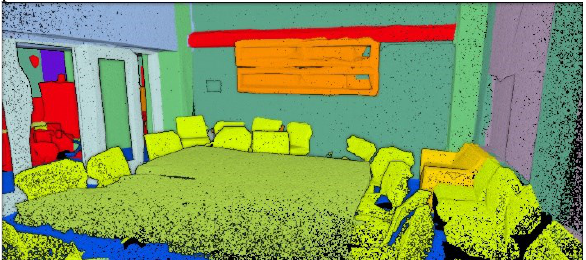
Figure 5 Result of the classification in a conference room